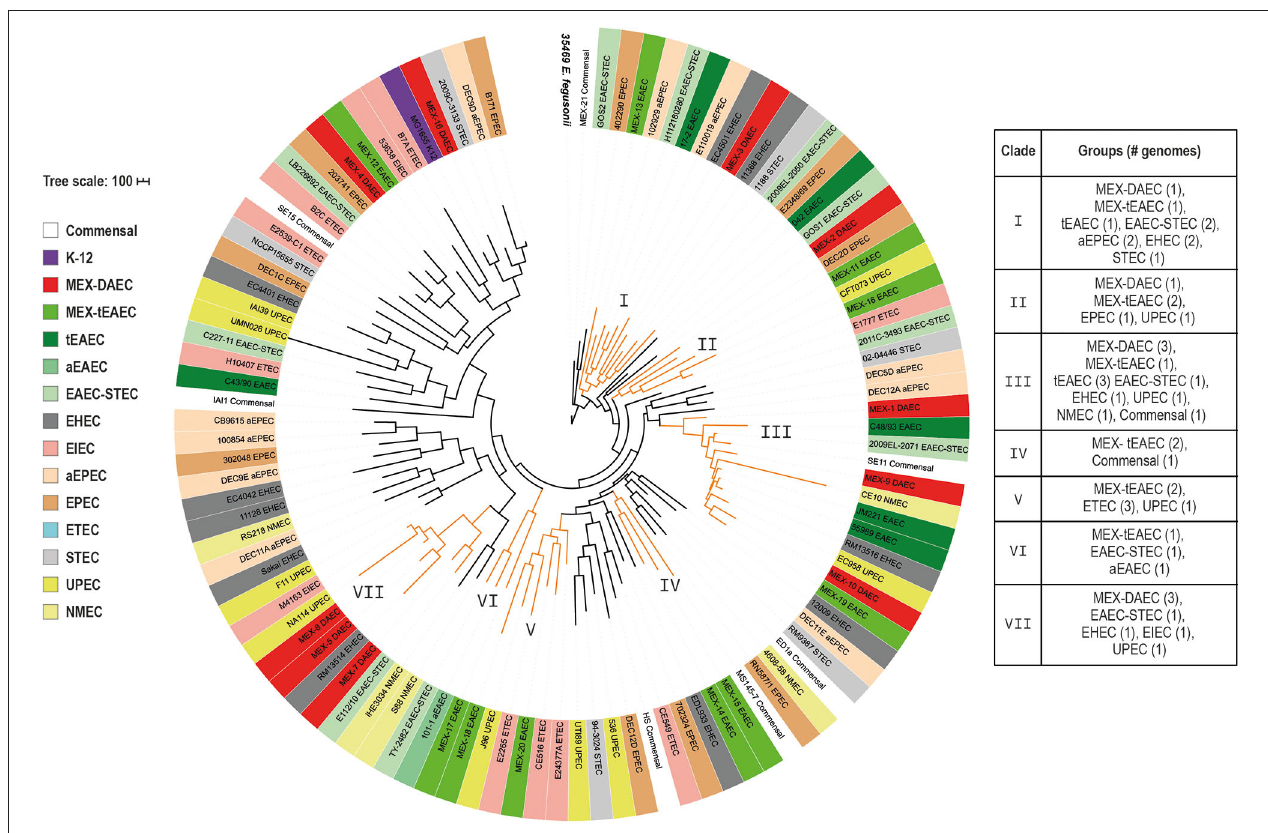
FIGURE 1 | Pan-genome phylogenetic tree. The tree was built up based on the presence or absence of 25,726 genes comprised in the E. coli pan-genome. E. fergusonii 35,469 (in bold) was included to root the tree. Each E. coli group is indicated by a different color listed in the left box. Clades including more than one DAEC or tEAEC genomes are highlighted in orange and the roman numeral indicates the clade number. The scale bar represents the number of differences in the presence or absence of genes among all